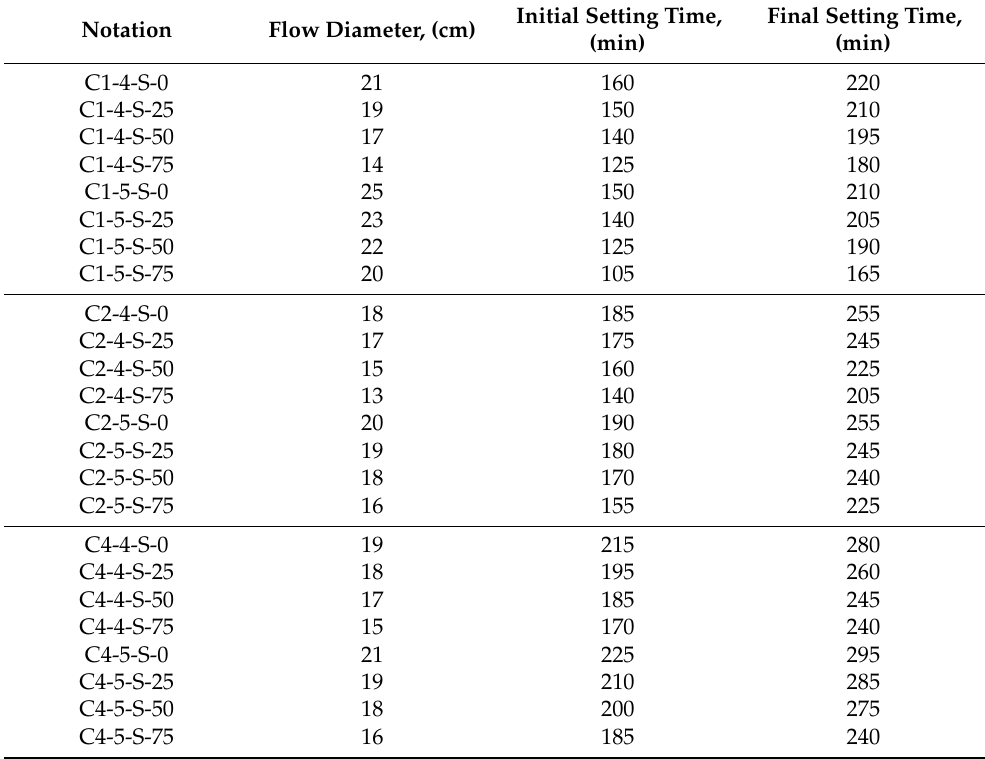
Table 4. Test results of flow table and Vicate